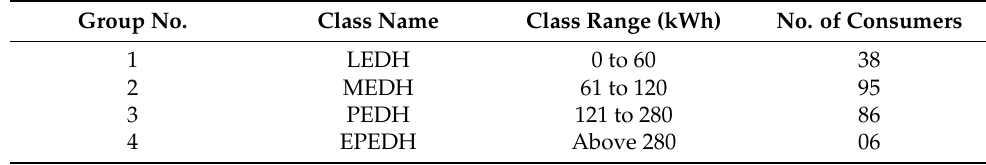
Table 6. Consumers’ class formation of 225 houses. Group